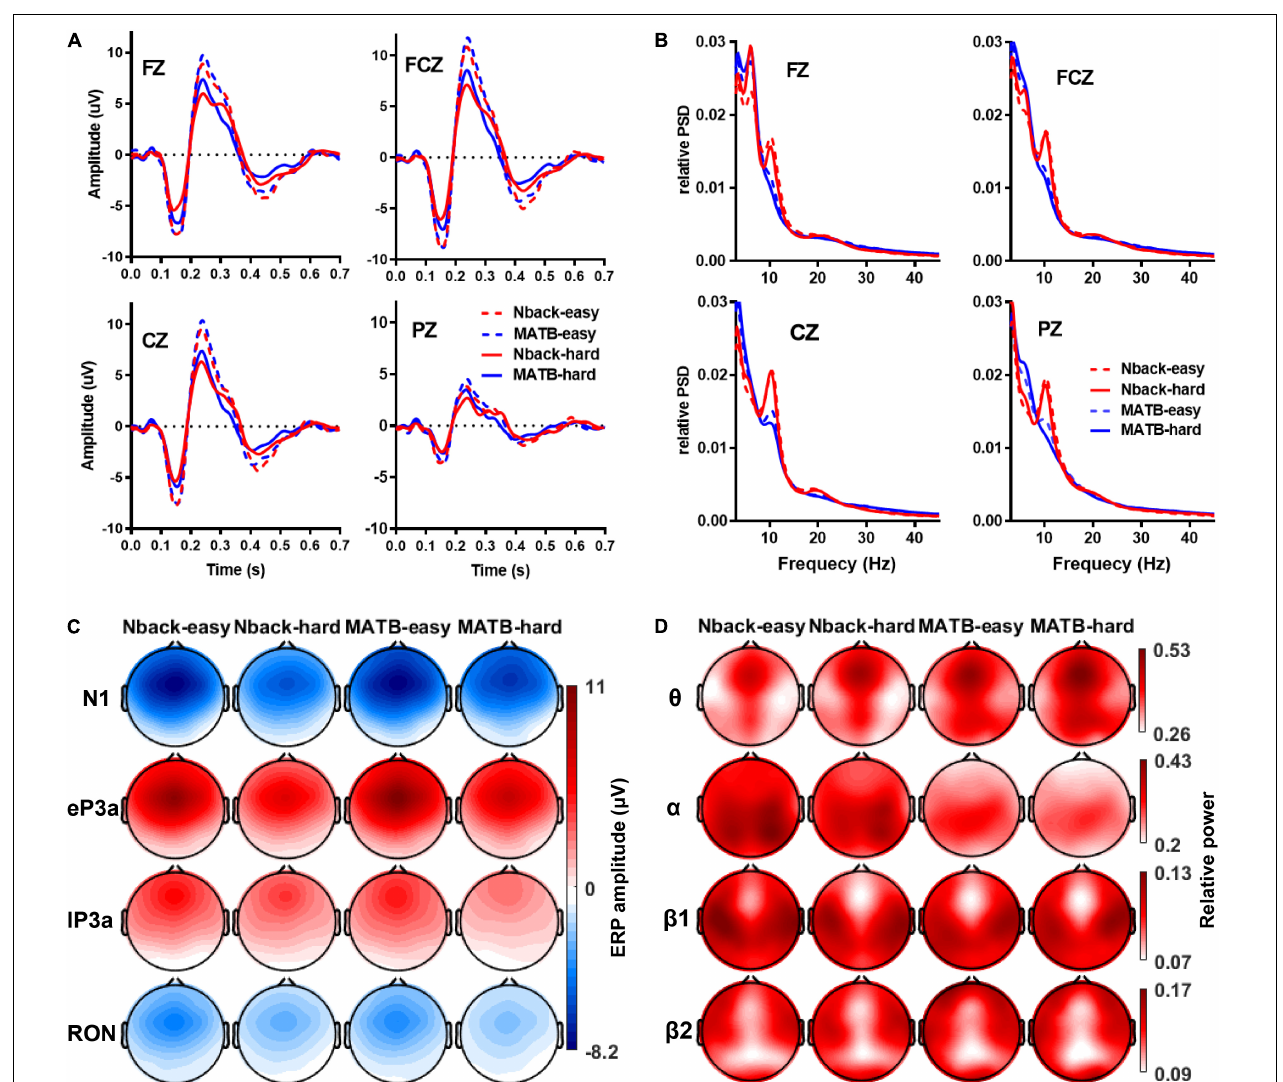
FIGURE 2 | (A) Grand average event-related potentials (ERPs) in each condition. (B) Grand average relative power spectral density in each condition. (C) The topological maps of the grand average ERP amplitude of the four components in each condition. (D) The topological map of the grand average relative powers of the four bands in each